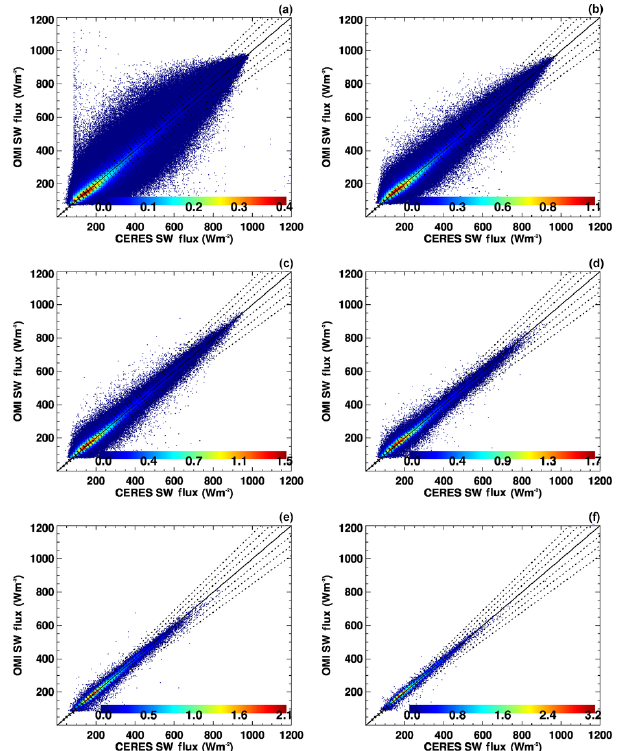
Figure 8. Two-dimensional histograms (similar to Fig. 5) of the daily OMI and CERES TOA SW flux averaged over different spa- tial grid sizes for July 2007: (a) at OMI’s native pixel resolu- tion, (b) 0.5 ◦ × 0.5 ◦ , (c) 1 ◦ × 1 ◦ , (d) 2 ◦ × 2 ◦ , (e) 5 ◦ × 5 ◦ , and (f) 10 ◦ × 10 ◦ . The corresponding statistical parameters are listed in Table 2. Model “h” is used to produce these results. The three dotted lines are 5, 10, and 15% error envelope